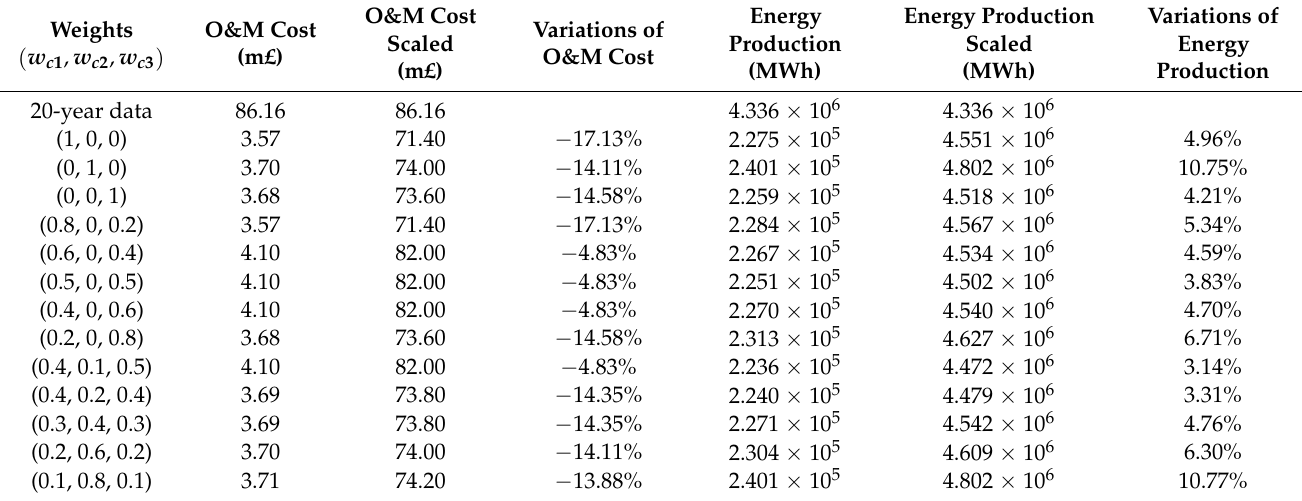
Table 2. O&M simulation results from the representative met-ocean reference year yielded by different combinations of component weighting